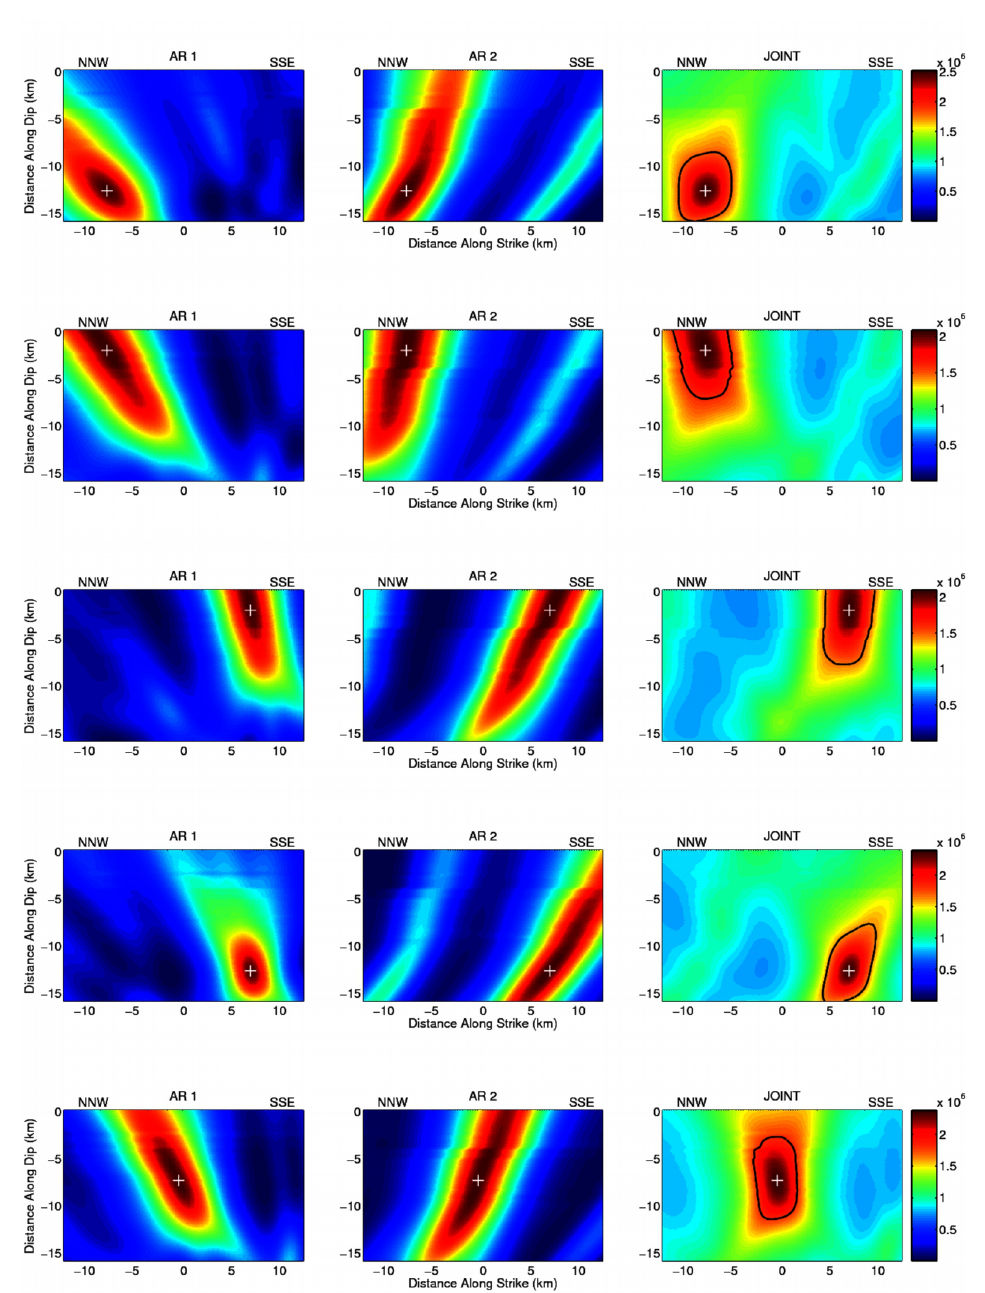
Figure 4 – Images of the beam power for a set of five synthetic sources (white crosses) positioned at different locations on the model fault plane. For each row, and from left two right, images refer to results from sub­array AR1, sub­array AR2, and the joint solution. Each source is analyzed separately; the dashed black lines bound those regions of the power spec­ tra which are 1dB above the background spectral